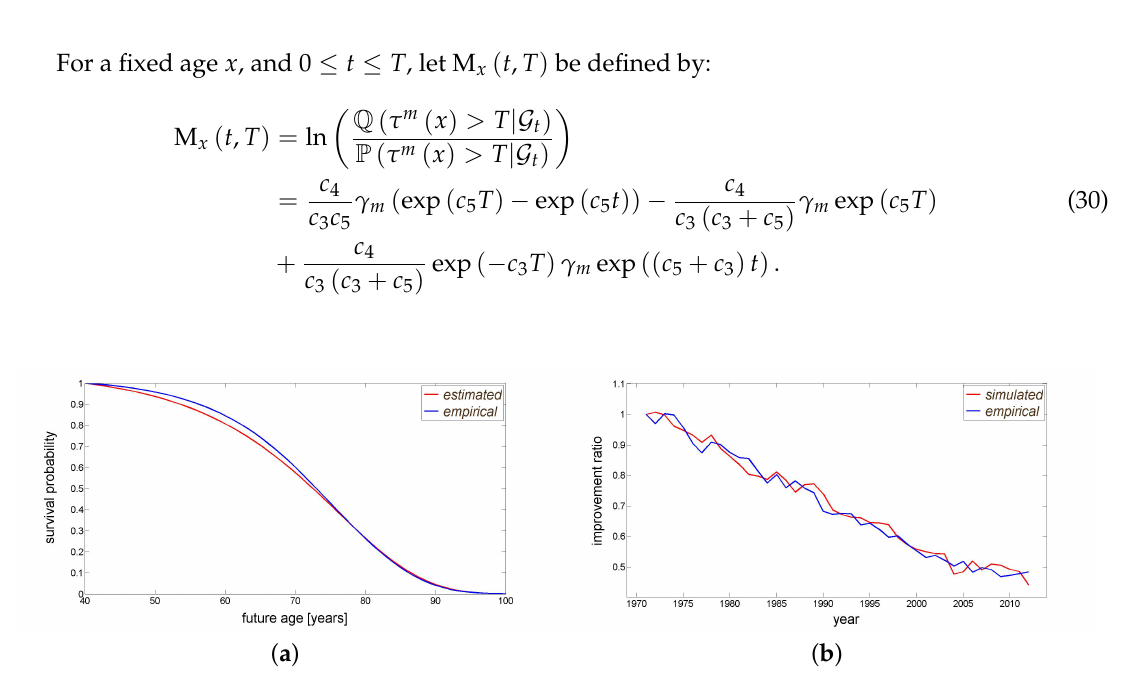
Figure 4. Gompertz Model ( a ) and Improvement Ratio ( b ) for Men Aged 40 Years in